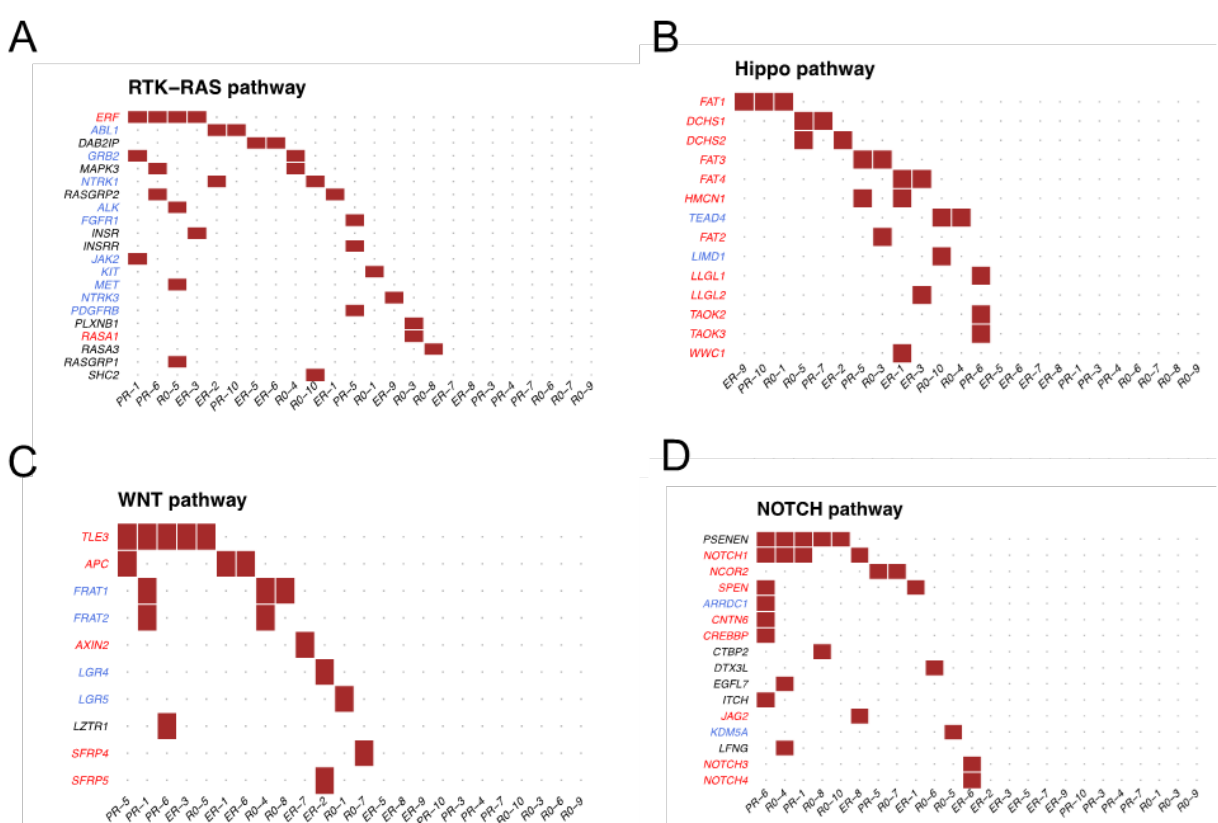
Figure 2. Altered genes for each patient in the four most frequently altered pathways. ( A ) RTK-RAS pathway, ( B ) Hippo pathway, ( C ) WNT pathway, ( D ) NOTCH pathway. Tumor suppressor genes are in red, and oncogenes are in blue.